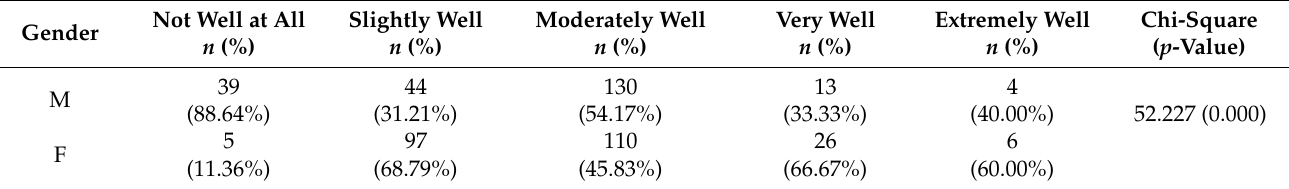
Table 7. Emotional well-being coping strategies of gender variable.